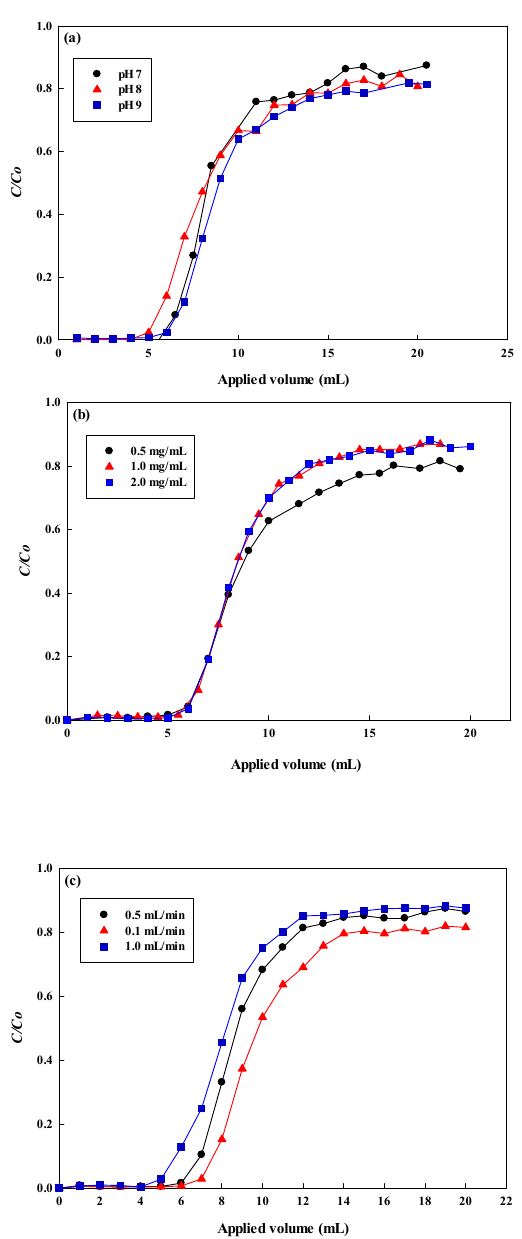
Figure 10. Continuous flow process for the removal of lysozyme by P-COOH-CS-RG19 nanofiber membrane (one piece membrane 0.03 g, effective area 3.7 cm 2 ): ( a ) pH (7–9) at a constant lysozyme concentration (2.0 mg/mL) and flow rate (0.5 mL/min), ( b ) lysozyme concentration (0.5–2.0 mg/mL) at a constant pH 9 and flow rate 0.5 mL/min, ( c ) flow rate (0.1–1.0 mL/min) at a constant pH 9 and concentration 2.0 mg/mL.